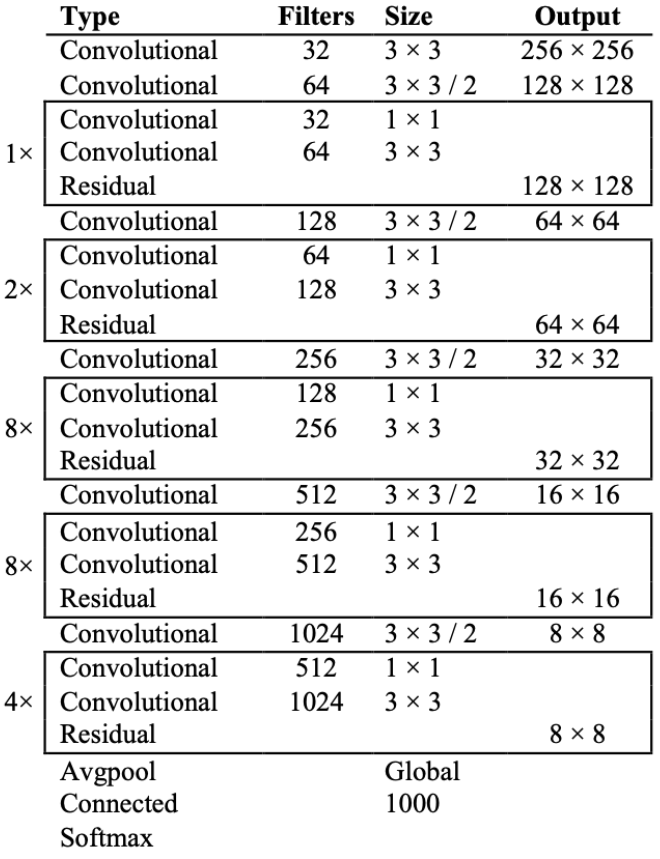
Figure 5. The architecture of Darknet-53 [8].